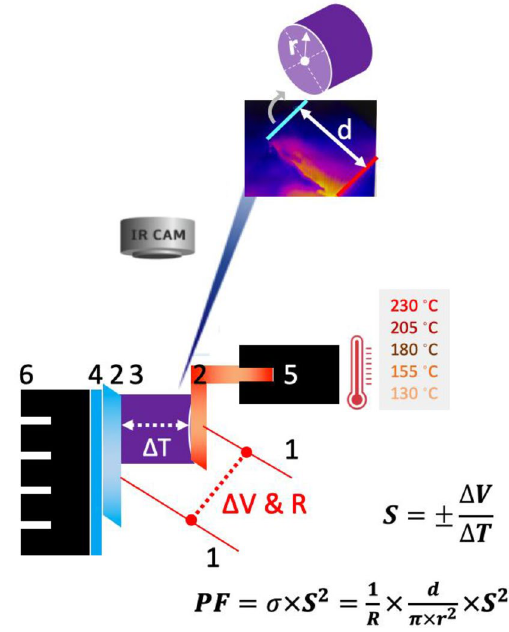
Fig. 1 A schematic of the cross-sectional view of the home-made apparatus for the Seebeck measurements of bulk thermoelectrics. 1, Nano-voltmeter probes to measure the thermo-voltage; 2, conductive tapes attached to the C-paste-based electrodes on the cylinder faces; 3, Mg